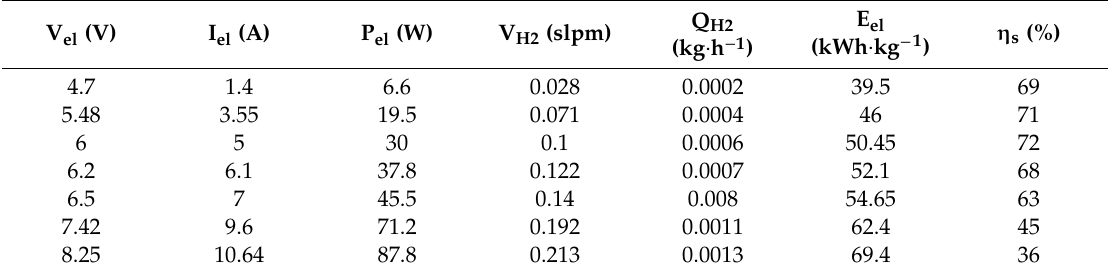
Table 2. Performance and operation of the PEM